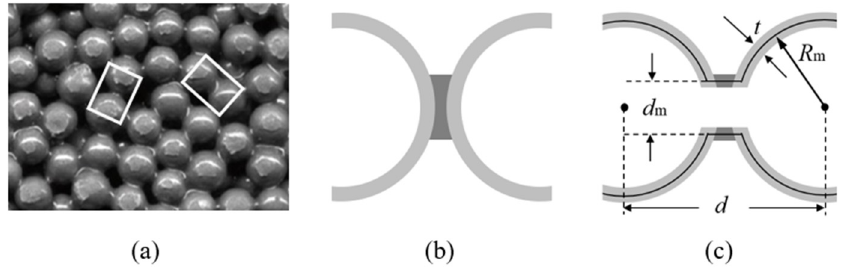
Figure 1. ( a ) Traditional MHSS; structure of two connected spheres ( b ) without and ( c ) with perforations.